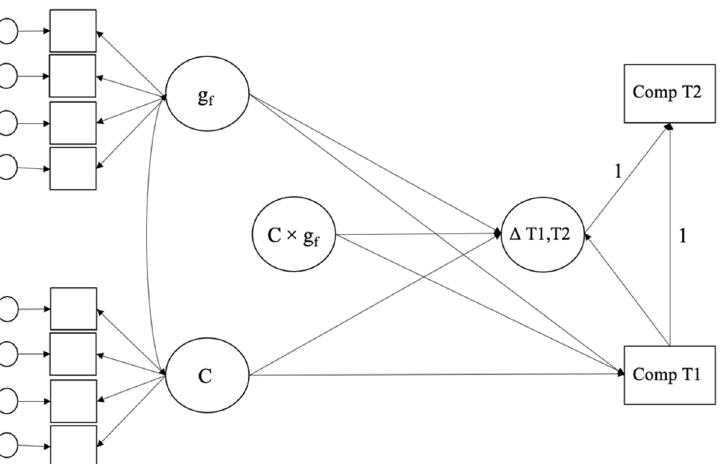
Figure 1. Schematic representation of the latent change regression model predicting initial levels (Comp T1) and changes ( Δ T1,T2) in competencies from T1 to T2 from conscientiousness (C), fluid intelligence (g f ), and their interaction (C × g f ). Note. Squared boxes represent manifest indicators, whereas bubbles represent latent variables. For parsimony, covariates are omitted.